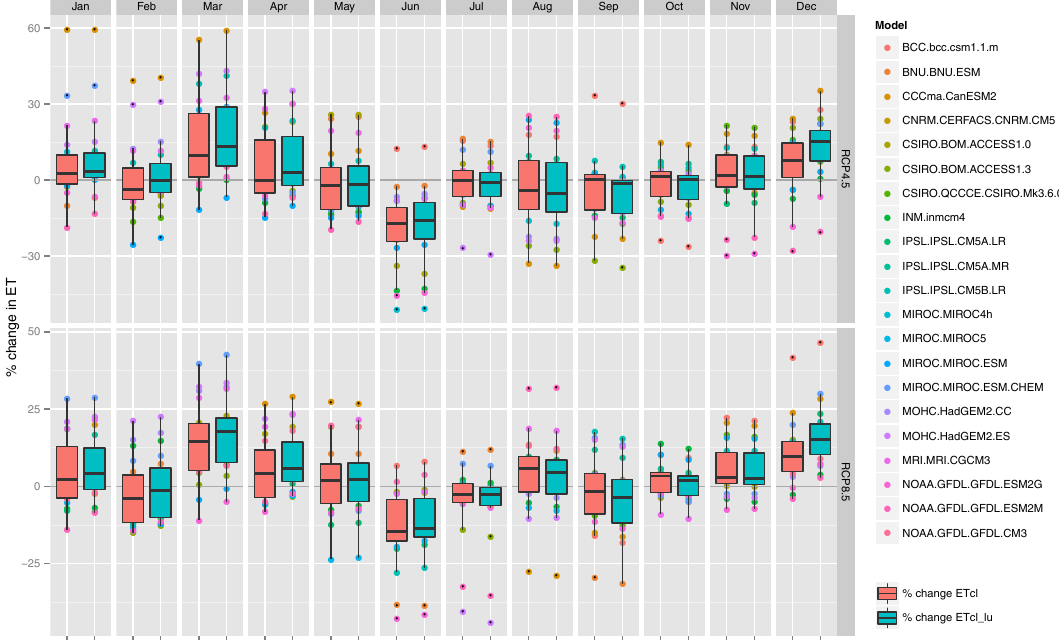
Figure B4. Percentage changes in evapotranspiration (ET) fluxes between the historical simulation period 2000–2005 and the future projec- tion simulation period 2030–2035 for the Upper Ganges basin and for each of the emission scenarios (RCP4.5 and RCP8.5). Pink colour corresponds to the scenarios where only climate change is taken into account. Blue colour corresponds to the scenarios where both climate change and land-use change are taken into